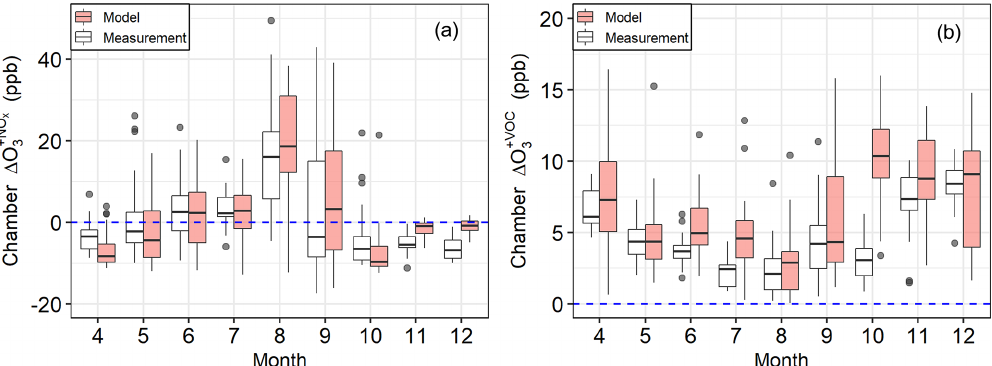
+ NO x (a) and (cid:49) O + VOC (b) predicted by the chamber model (solid box) and directly measured in 3 3